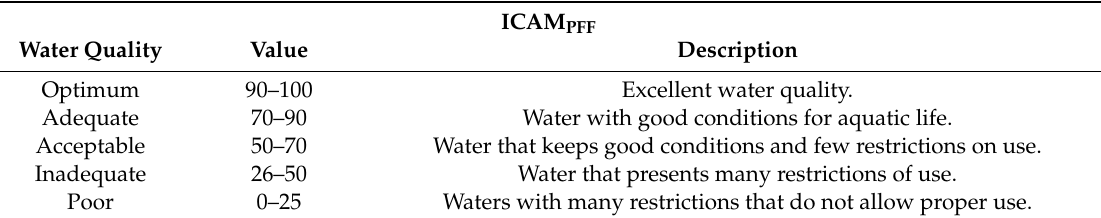
Table A8. ICAMPFF classification